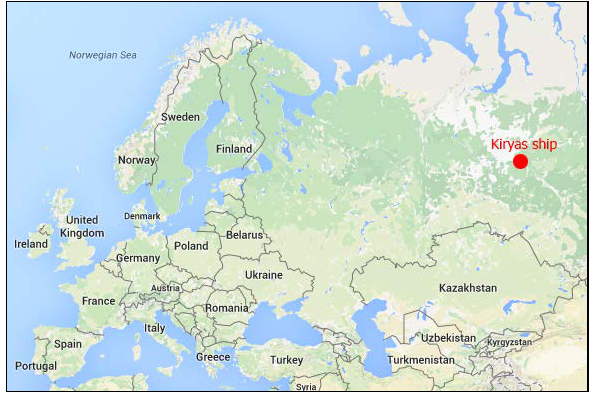
Figure 1. Location map of Kiryas